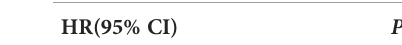
TABLE 2 Univariate and multivariate Cox analyses for OS in EC patients with lung